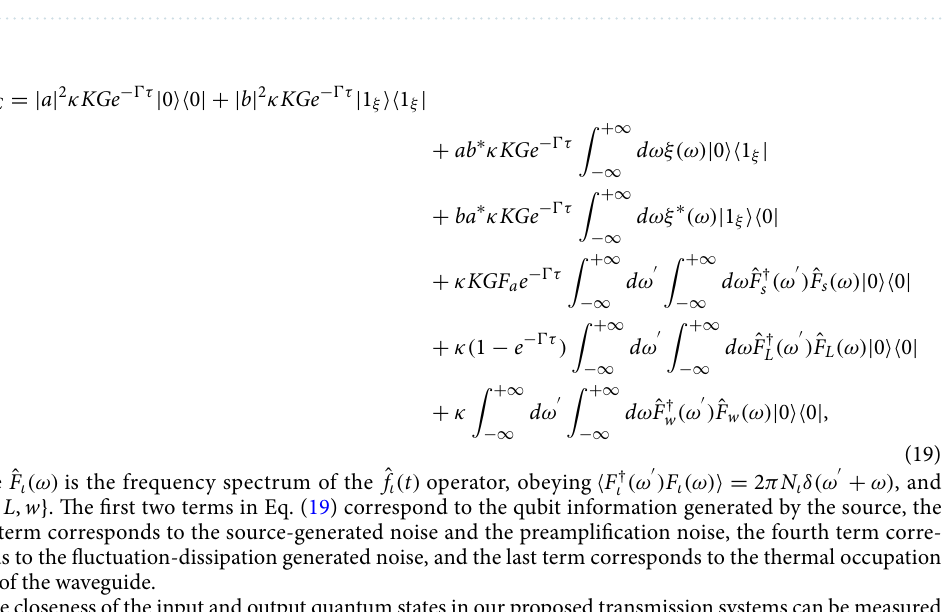
Figure 4. ( a ) The transmission fidelity D t versus the gain. A waveguide length l = 100 m and a transmittance of unity are considered. ( b ) The transmission fidelity D t versus the waveguide length. A gain G = 40 and a transmittance of unity are